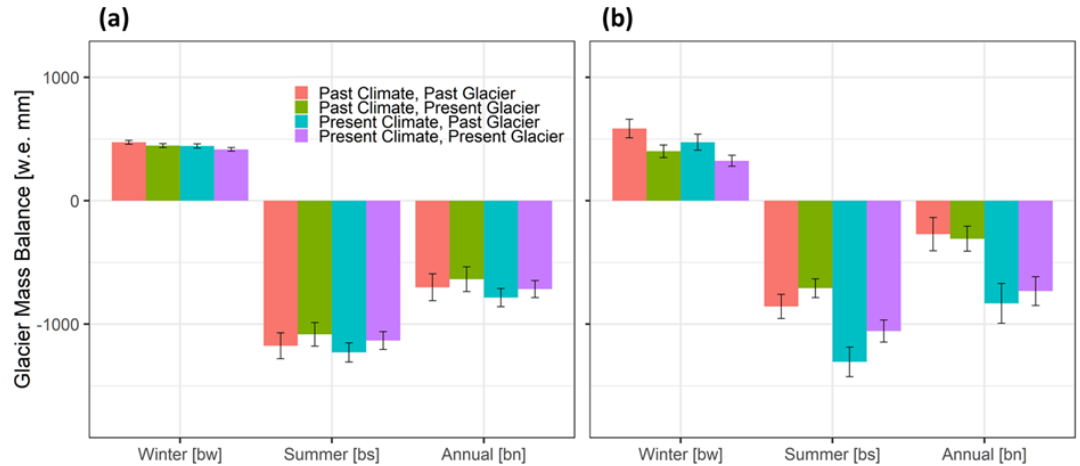
Figure 6. Glacier mass balance during winter, summer, and annual periods from the four model scenarios, A–D, combining past and present climate and glacier. Error bars show the annual variability, defined as the standard error between years. (a) AGRB. (b) PGRB.